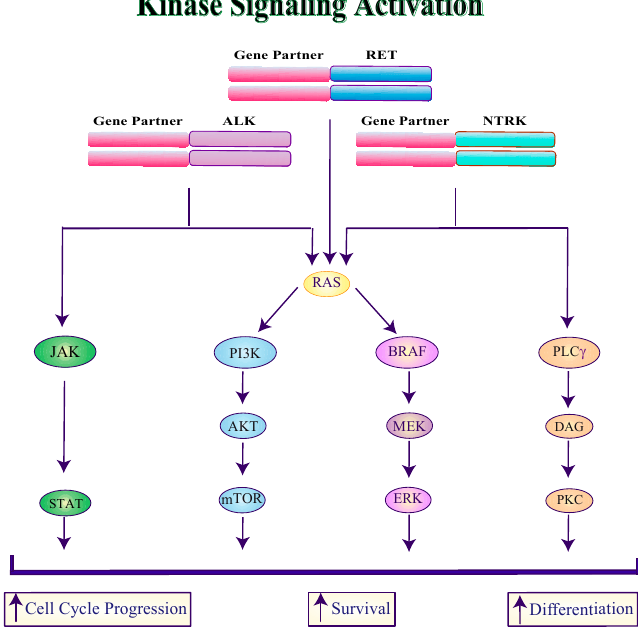
Figure 2. Schematic overview of ALK, NTRK and RET fusion proteins signaling. The indicated fusion proteins activate the JAK / STAT, PI3K, MAPK and PLC γ pathways involved in cell cycle progression, survival and di ff erentiation. ALK, anaplastic lymphoma kinase; NTRK, neurotropic tropomyosin receptor kinase; RET, rearranged during transfection; RAS, Rat Sarcoma; JAK, Janus kinase; STAT, signal transducers and activators of transcription; PI3K, phosphoinositide 3-kinase; AKT, V-Akt Murine Thymoma Viral Oncogene Homolog; mTOR, Mammalian Target of Rapamycin; BRAF, B-Raf proto-oncogene; MEK, Mitogen-Activated Protein Kinase; ERK, Extracellular Signal-Regulated Kinase; PLC γ , phospholipase C- γ ; DAG, Diacylglycerol; PKC, protein kinase C.